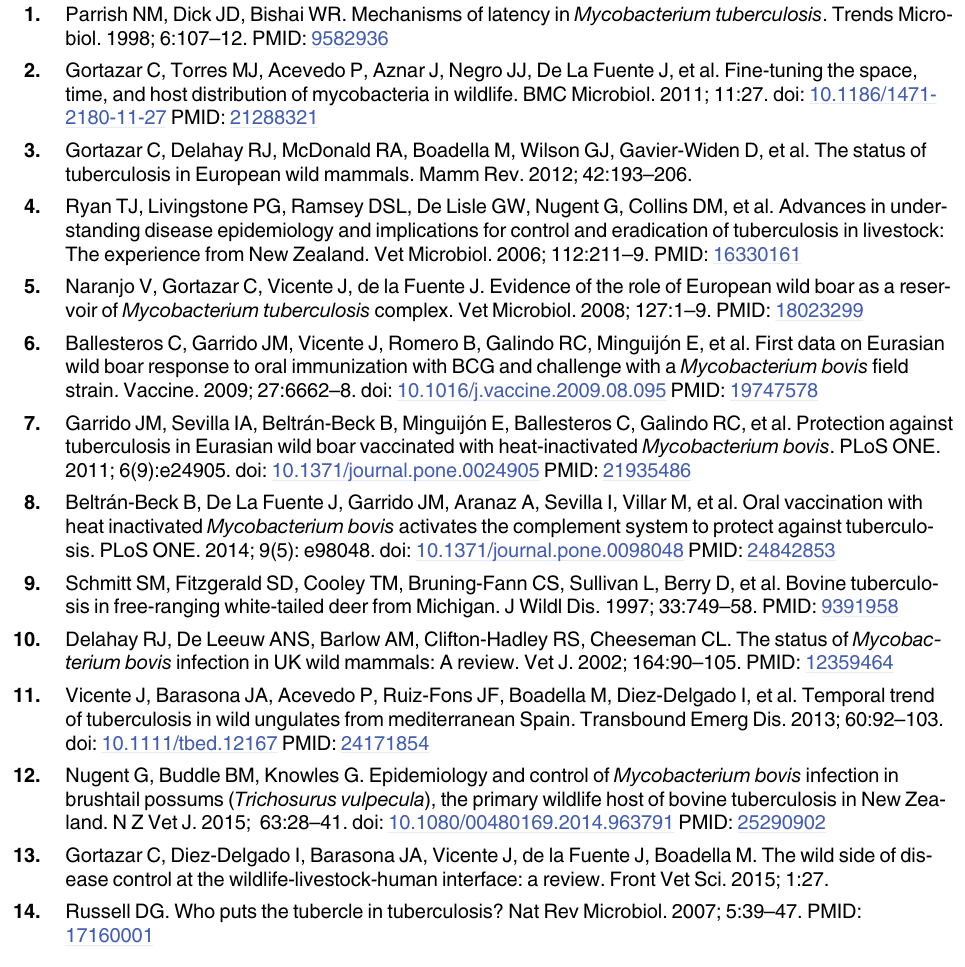
S3 Table. Stress response and lipid metabolism proteins identified in the MB1-MB4 genomes. S4 Table. Antigens selected for analysis in the MB1-MB4 isolates. S5 Table. ESX proteins identified in the MB1-MB4 genomes. S6 Table. T-cell epitopes identified in the MB1-MB4